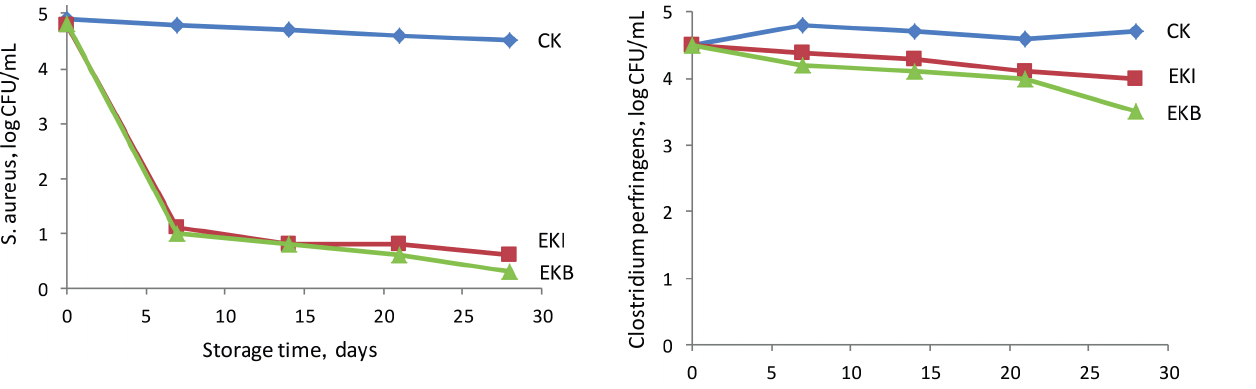
Figure 2 Dependence of Staphylococcus aureus concentration in kashk samples on storage time. CK: control kashk, EKI: experimental kashk with MIC (0.211 mg/mL of caper extract), and EKB: experimental kashk with MBC (0.350 mg/mL of caper extract)